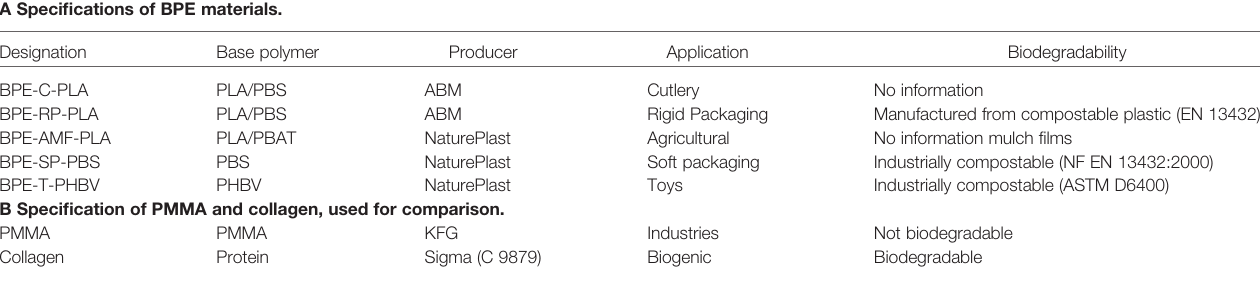
TABLE 2 | Speci fi cations of polymers used in this study. A Speci fi cations of BPE